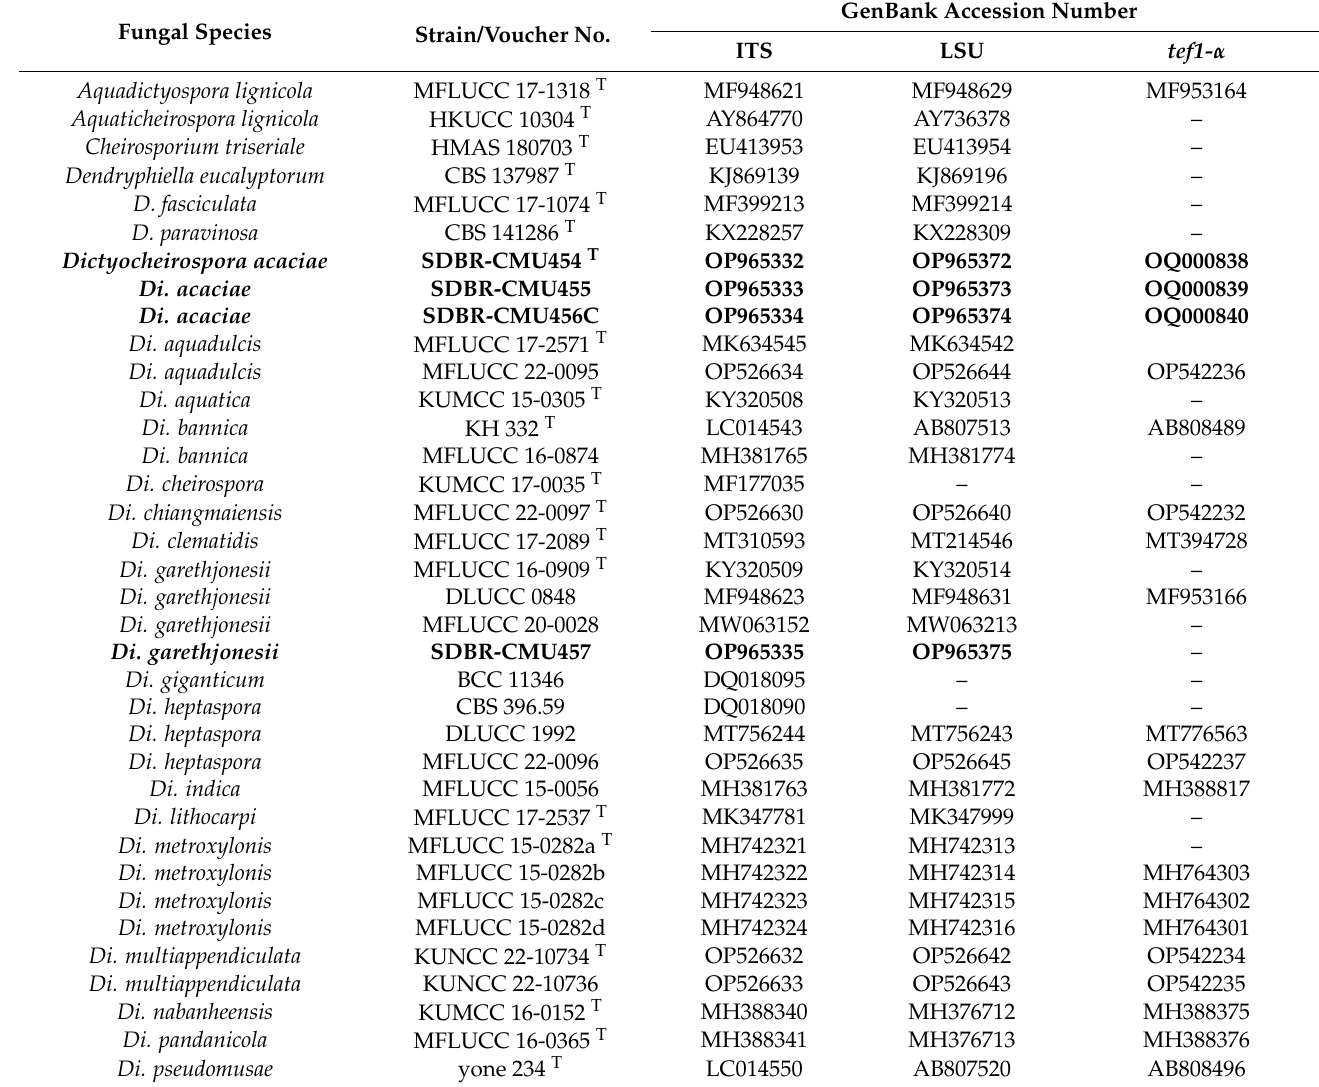
Table 1. GenBank and culture collection accession numbers of species included in the phylogenetic study. The newly generated sequences are shown in bold.